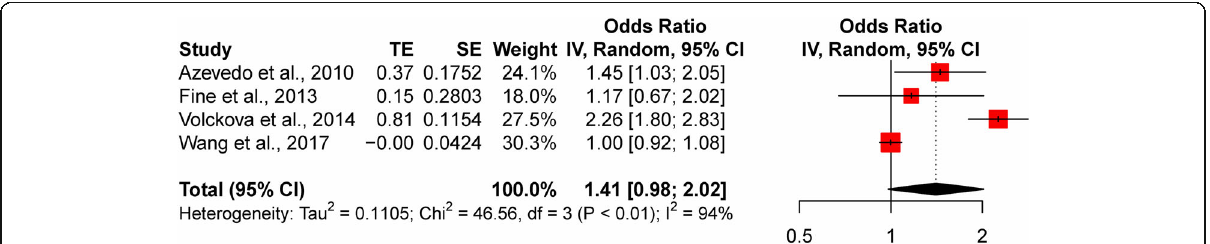
Fig. 3 Forest plot for meta-analysis of the association of rs1126478 with dental caries. Each study is represented by a square whose area is proportional to the weight of the study. The overall effect from meta-analysis is represented by a diamond whose width represents the 95% CI for the estimated OR. OR, odds ratio; CI, confidence